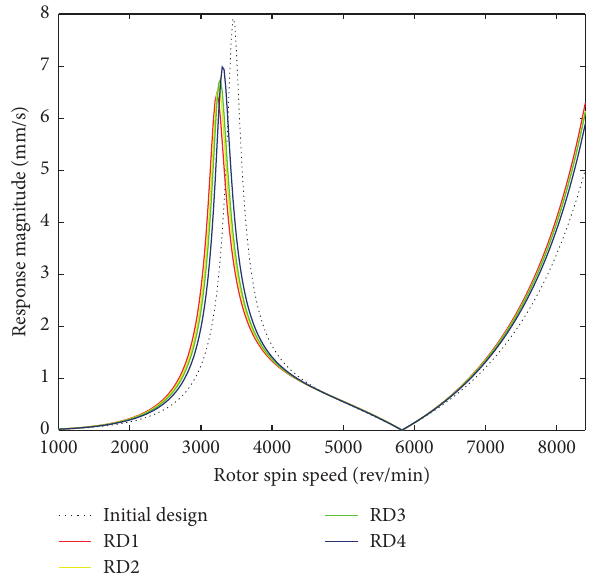
Figure 18: Initial design and the robust design